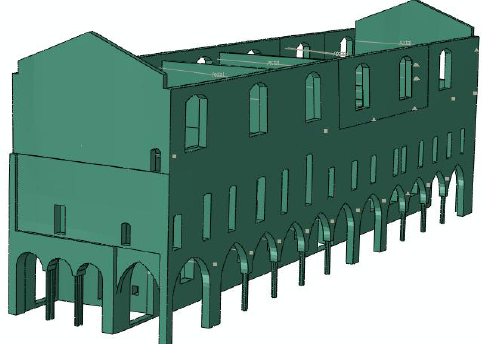
Figure 7. Geometrical model of the building in its current state. Lines represent the steel tie-rods.